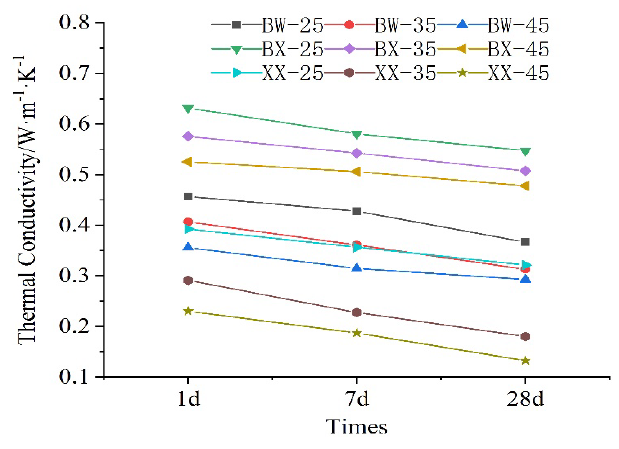
Figure 6. Change trend of thermal conductivity of test specimen with measurement time.